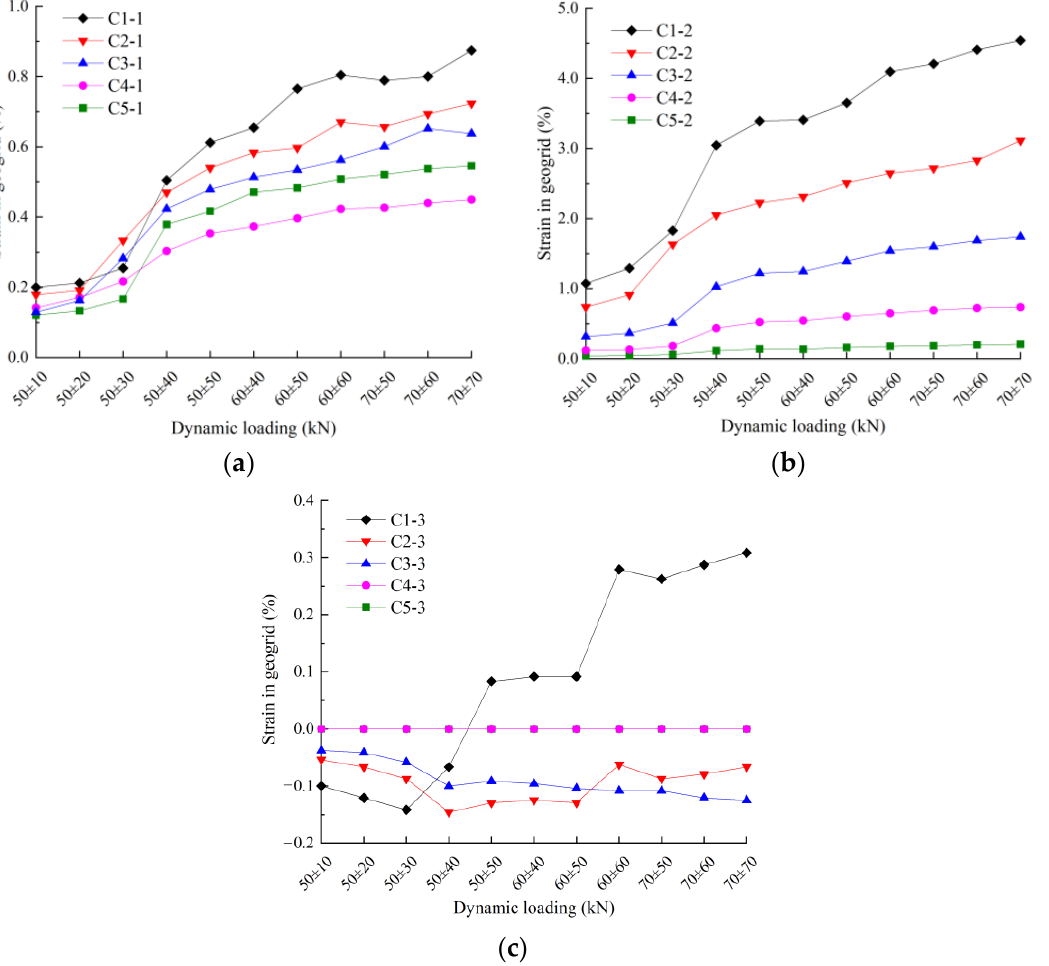
Figure 10. Geogrid strain (equal frequency loading). ( a ) Connection position to the facing panels. ( b ) Below the loading plate. ( c ) Anchorage position.